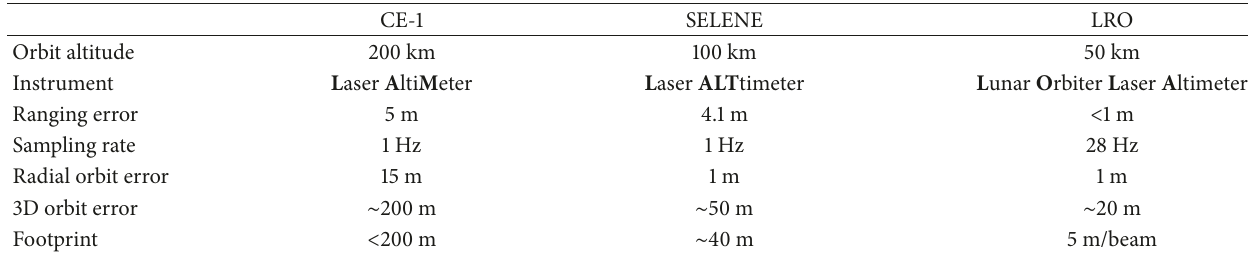
Table 1: Specifications of altimetry instrument on